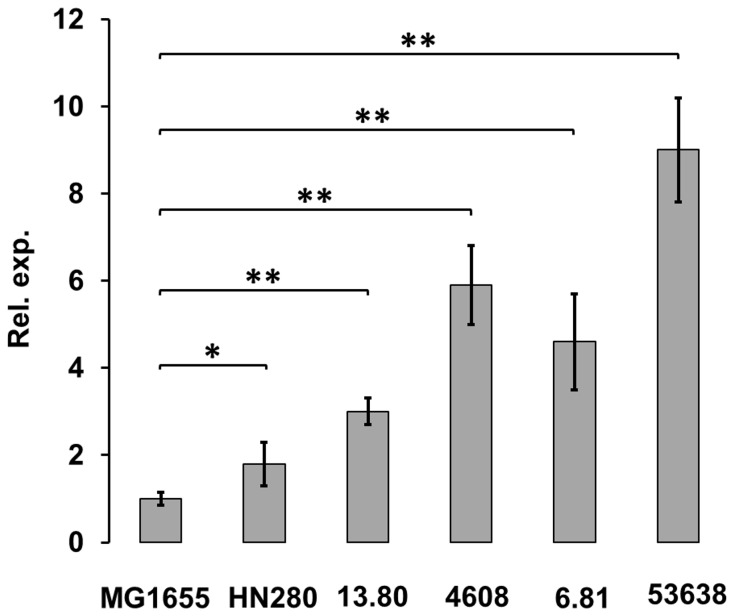
Expression of speC in EIEC strains.The in vivo speC transcription was monitored by Real-Time PCR and referred to the level observed in the MG1655 control. Strains were grown at 37°C in M9 complete medium. At least three wells were run for each sample and the error bars display the calculated maximum (RQMax) and minimum (RQMin) levels that represent standard error of the mean expression level (RQ value); * denotes 0.05>p≥0.01; ** denotes p<0.01.